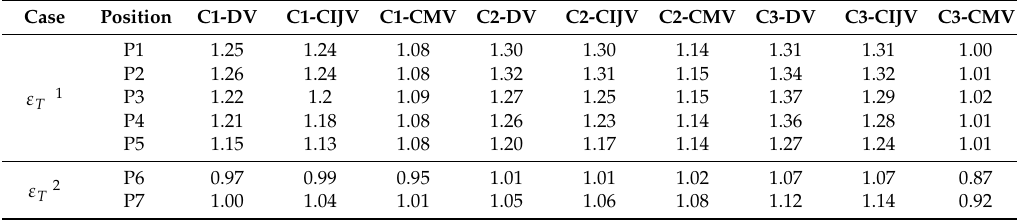
Table 5. Average ε T in locations P1–P7 for all